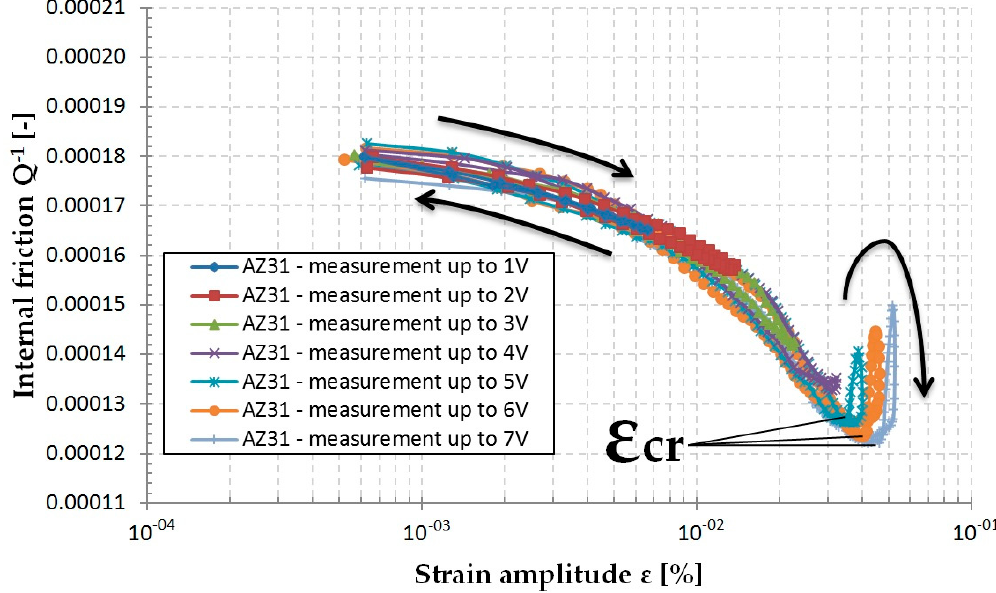
Figure 9. Amplitude dependencies of IF measured for AZ31 alloy and increasing maximum strain amplitudes.